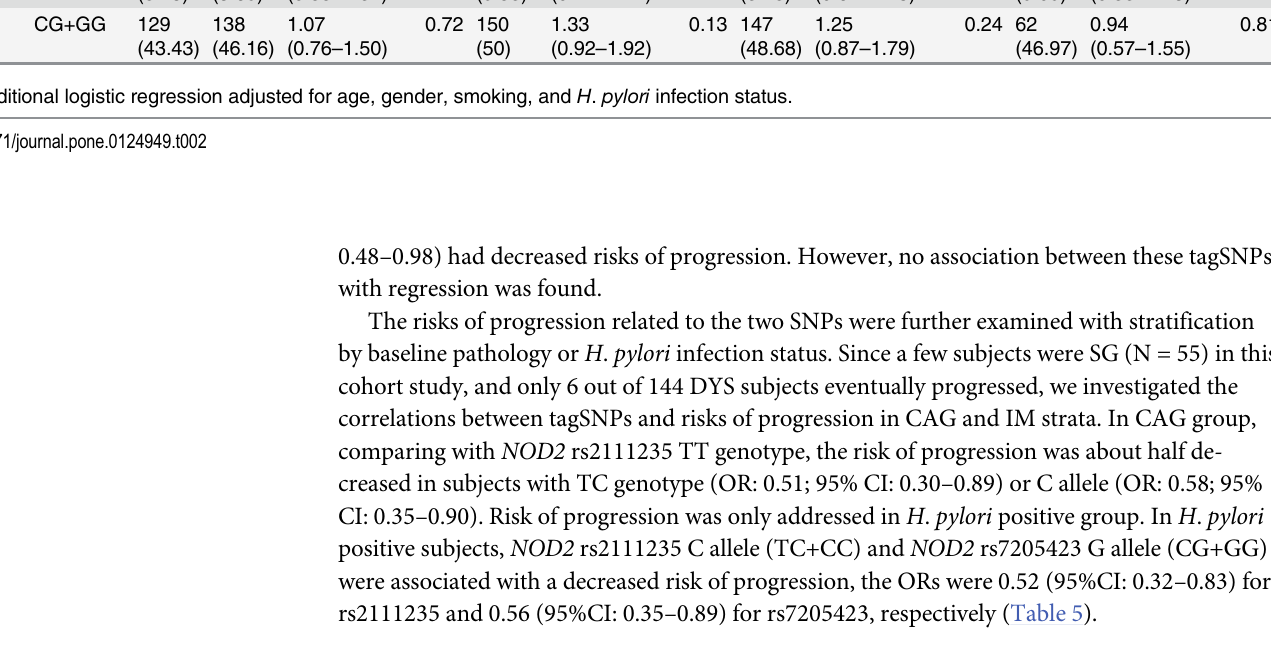
Table 3. Joint effect between polymorphisms and H . pylori infection on risk of precancerous gastric lesions and GC. Polymorphisms H .